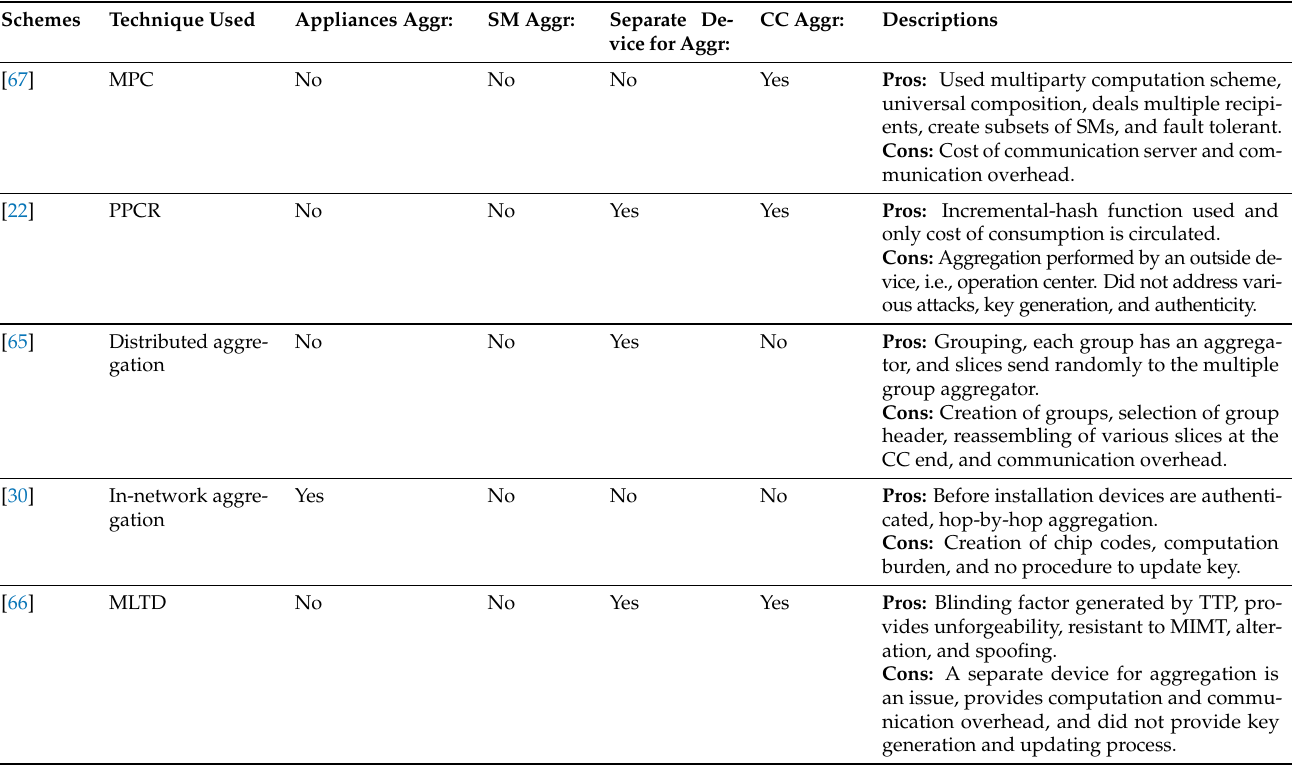
Table 1. Comparison of data aggregation